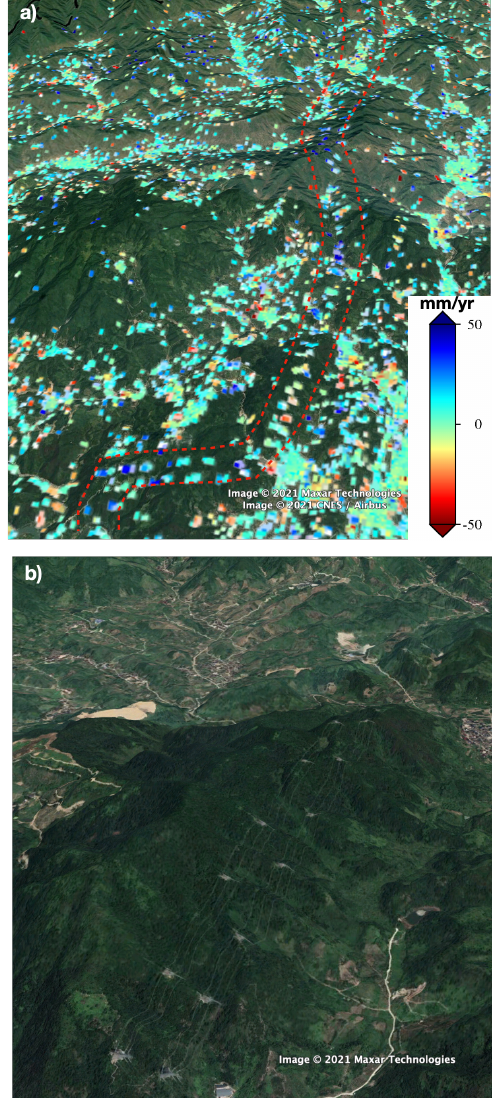
Figure 10 . (a) Subsidence velocities of high-voltage towers in the mountain area. (b) is the corresponding Google Earth TM image of